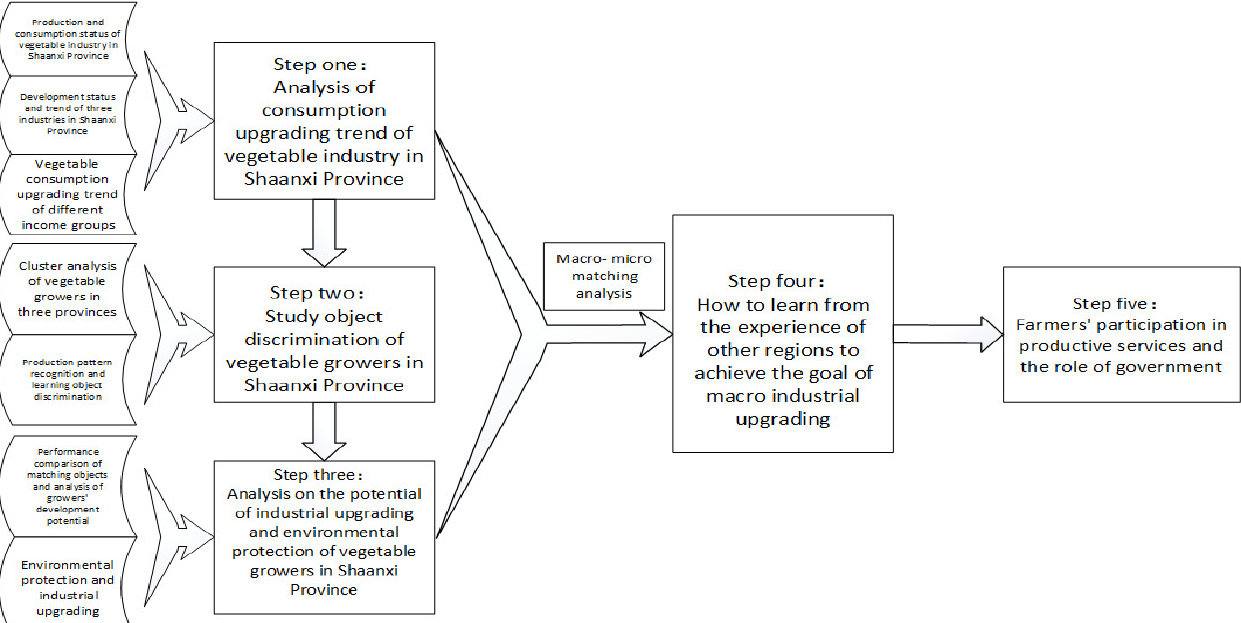
Figure 2. Logical framework diagram of five-step analysis of the upgrade of the vegetable industry in Shaanxi. in